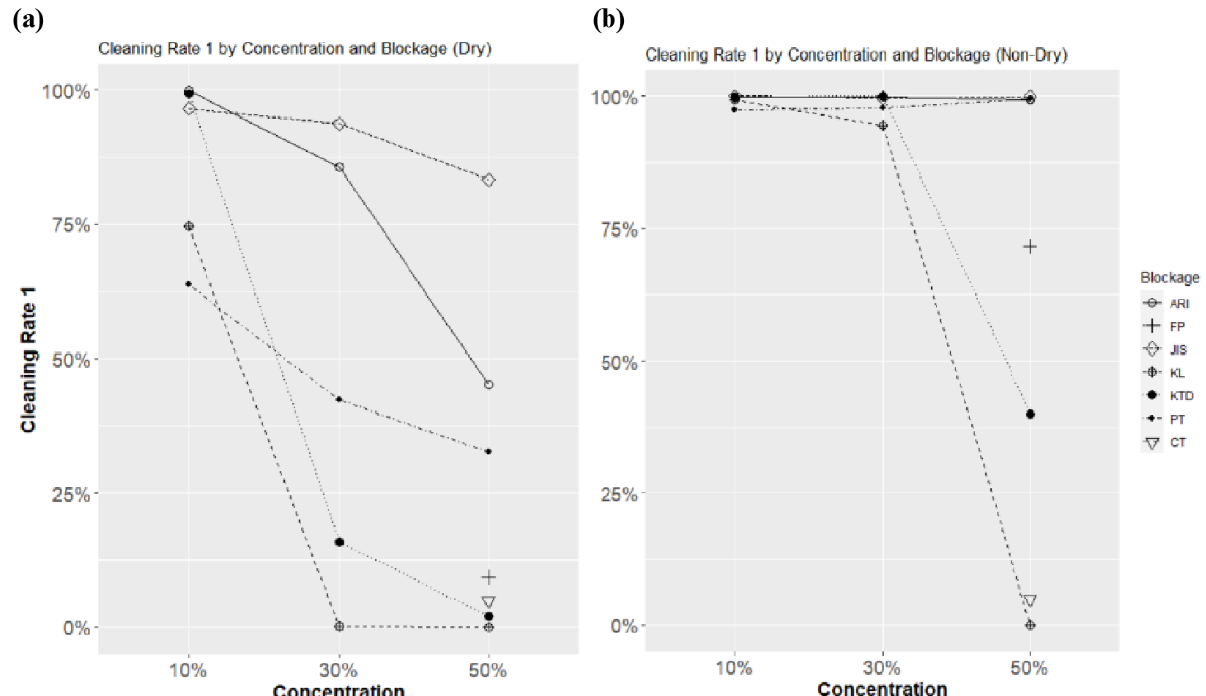
Figure 22. ( a ) Blockage and concentration cleaning rate result graph (dry), ( b ) blockage and concen- tration cleaning rate result graph (non-dry).